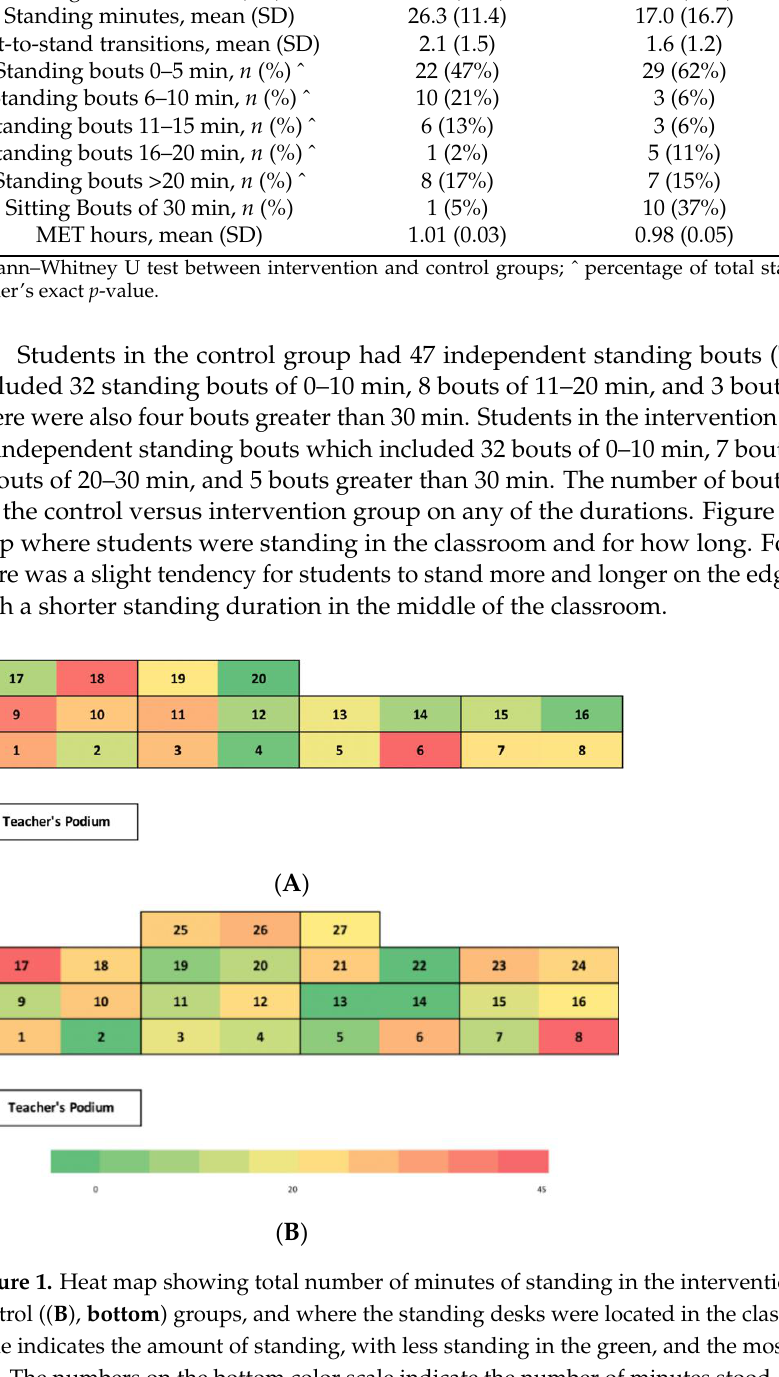
Table 2. Standing and sitting time of study participants during the 50 min lecture for those with ActivPAL data.